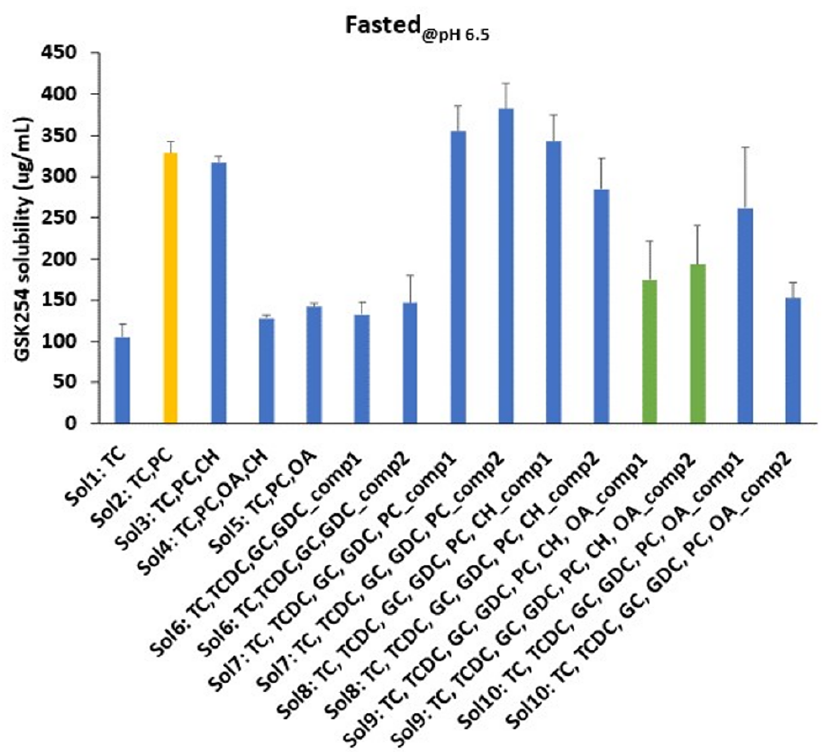
Figure 3. Bar chart (mean, ± SD) of GSK254 equilibrium solubility (24 h) values in different compo- sitions of fasted media at pH 6.5. sodium taurochenodeoxycholate (TCDC); sodium taurocholate hydrate (TC); sodium glycodeoxycholate (GDC); sodium glycocholate hydrate (GC); cholesterol (CH); oleic acid (OA); L-alpha- phosphatidylcholine from egg yolk (PC). Typical FaSSIF media com- position (yellow bar). Composition of the new media containing mixture of bile salts as well as OA and CH showing the negative impact of OA on GSK254 solubility (green bars). Refer to Table 2 for the exact recipe of composition 1 (comp1) and composition 2 (comp2); solubility measurements were conducted in each composition in triplicates (n = 3).